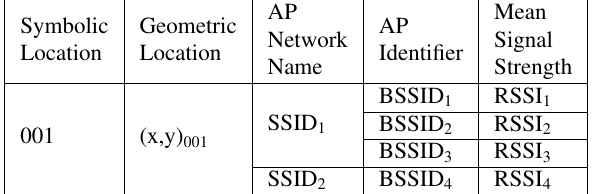
Table 1. Information restructured based on its Symbolic and Geometric